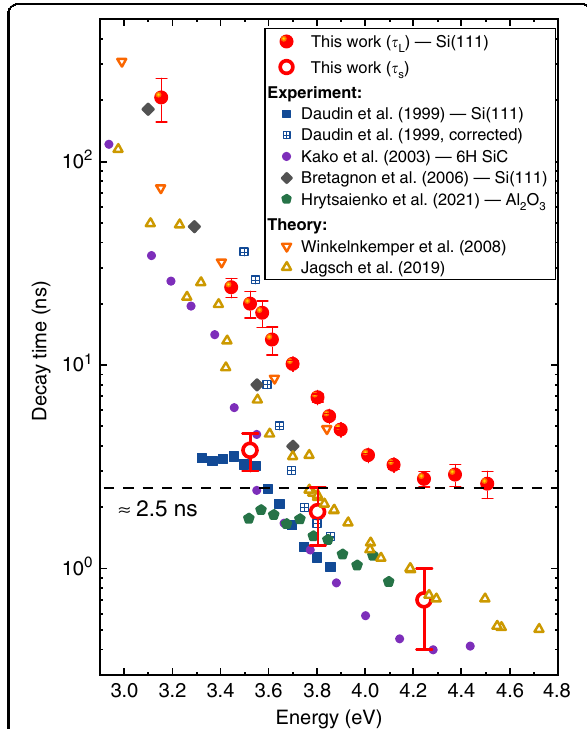
Fig. 12 Comparison of exciton decay times reported in GaN/AlN QDs at cryogenic temperature. Experimental results 62 – 65 are highlighted with fi lled markers and the substrate employed by each group is speci fi ed in the legend. Computed lifetimes (empty up and down triangles) 76,89 were obtained for various aspect ratios and QD heights. Crossed squares correspond to experimental results after subtraction of a nonradiative recombination component, as detailed in ref.